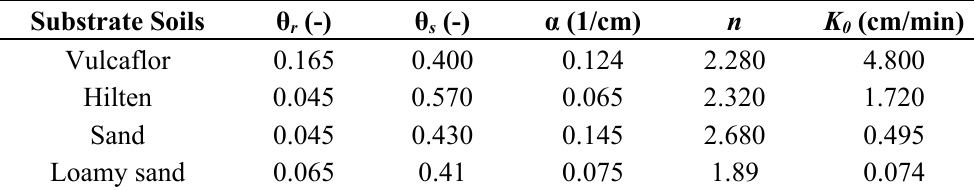
Table 1. Mualem-van Genuchten parameters for the selected